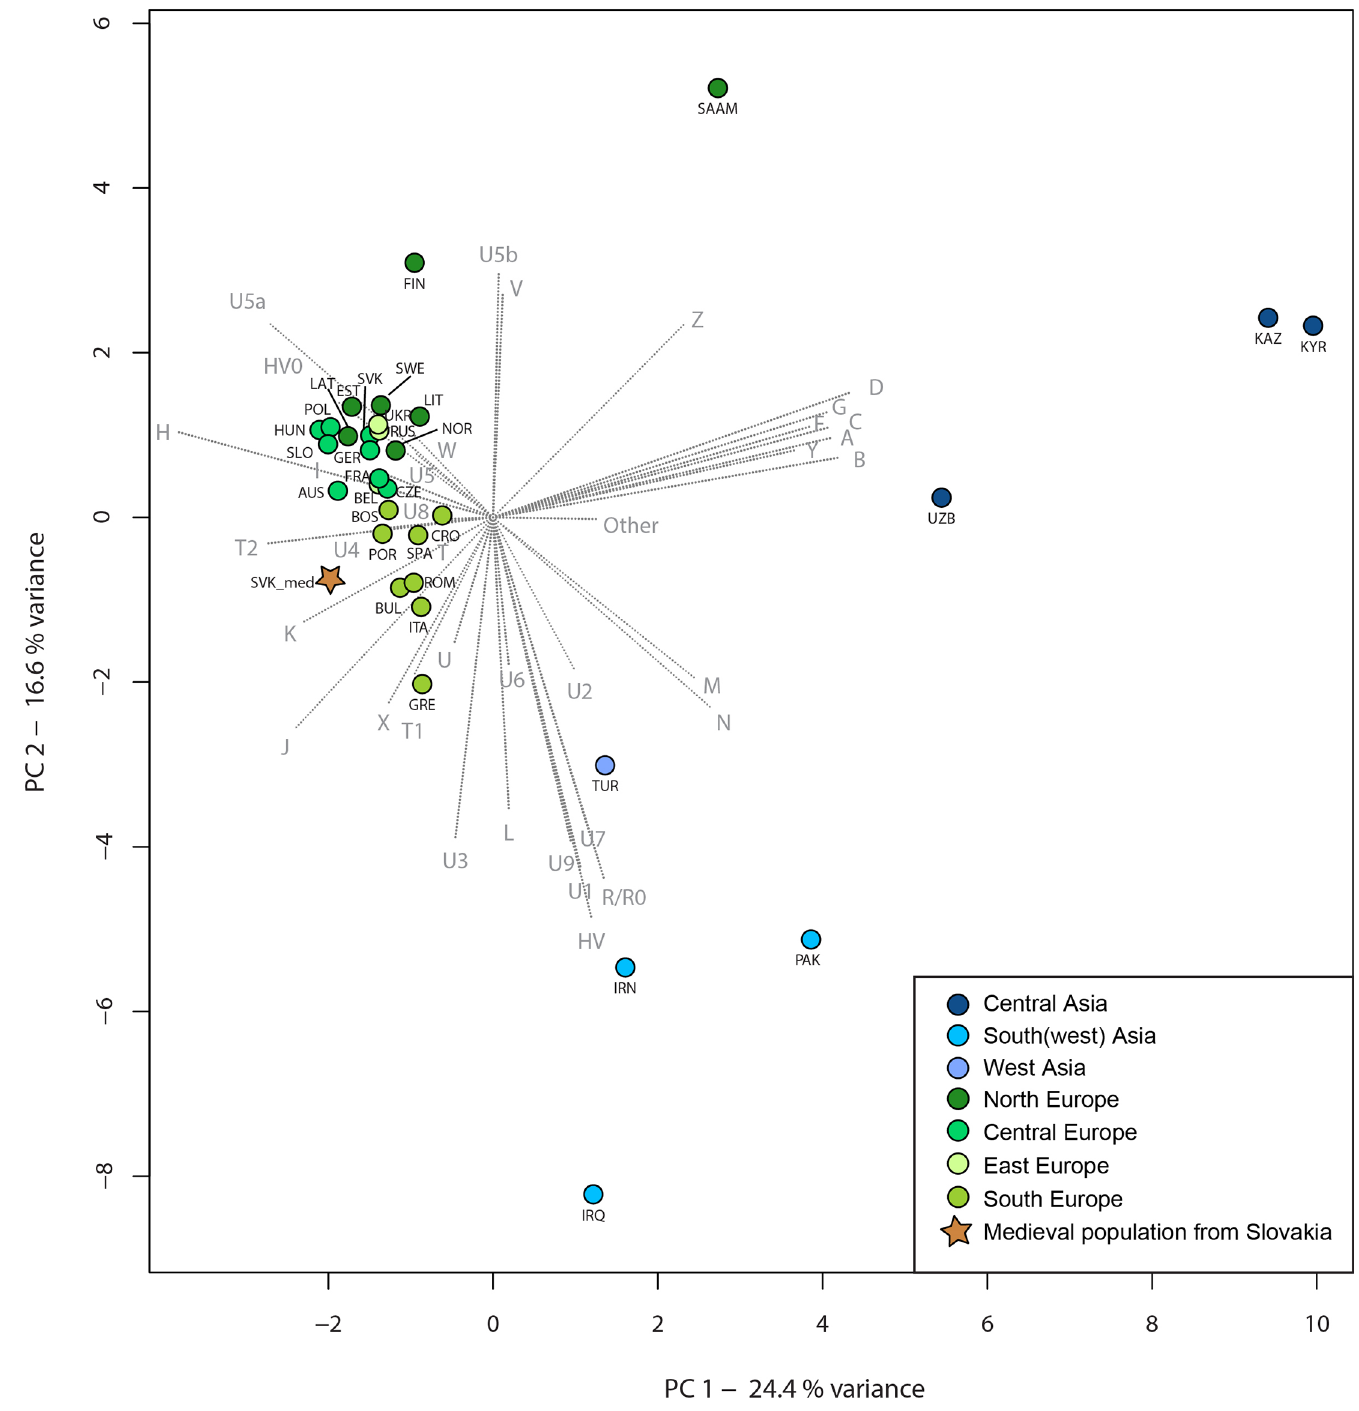
Fig 4. PCA of the investigated medieval and modern-day populations. The PCA is based on mtDNA haplogroup frequencies of the medieval population from Slovakia and 33 modern-day populations from Eurasia, and represents PC1 and PC2. For the frequencies and the list of abbreviations see S8 Table.